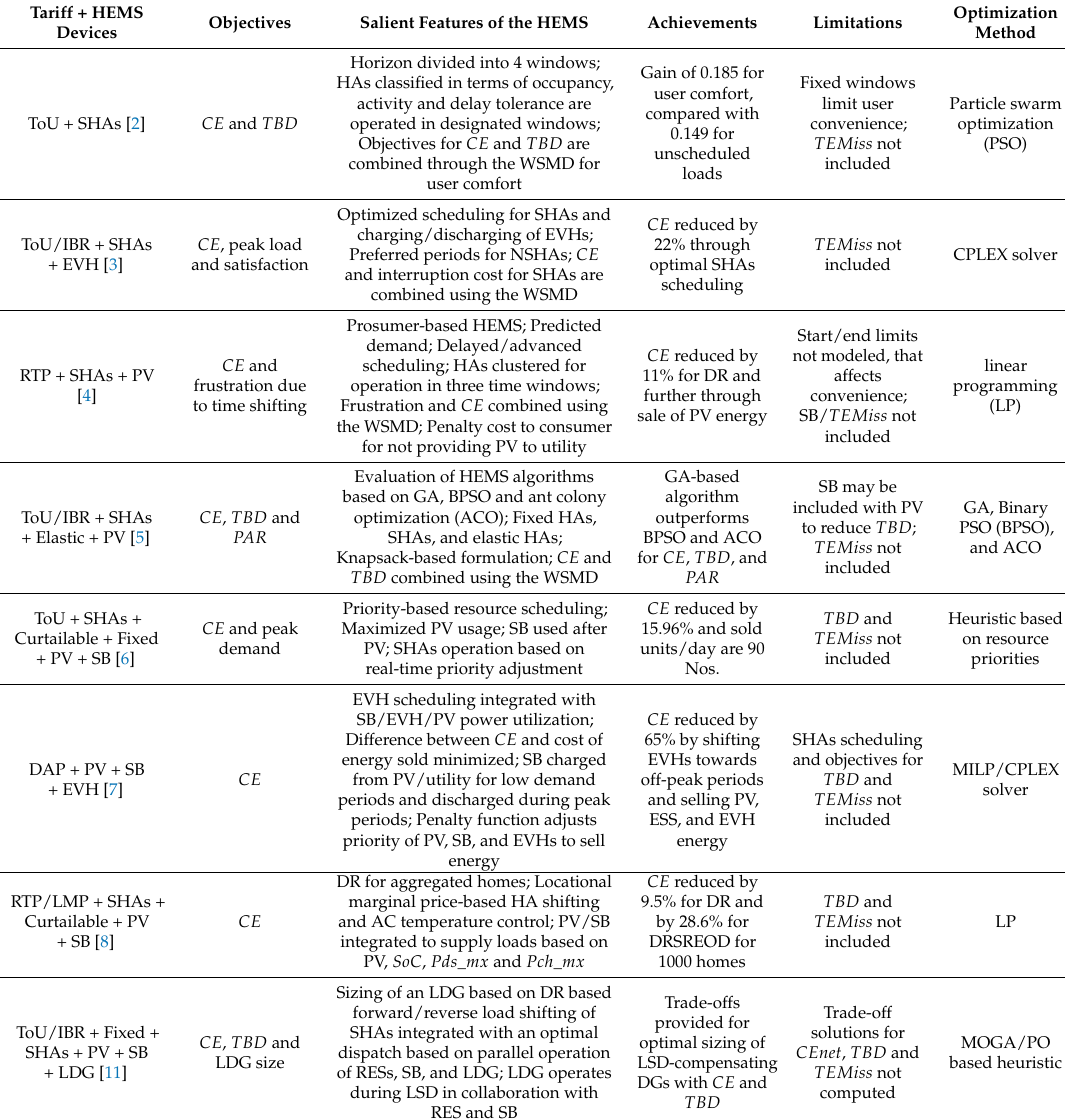
Table 3. Related work of proposed method for eco-efficient DRSREODLDG-based HEMS